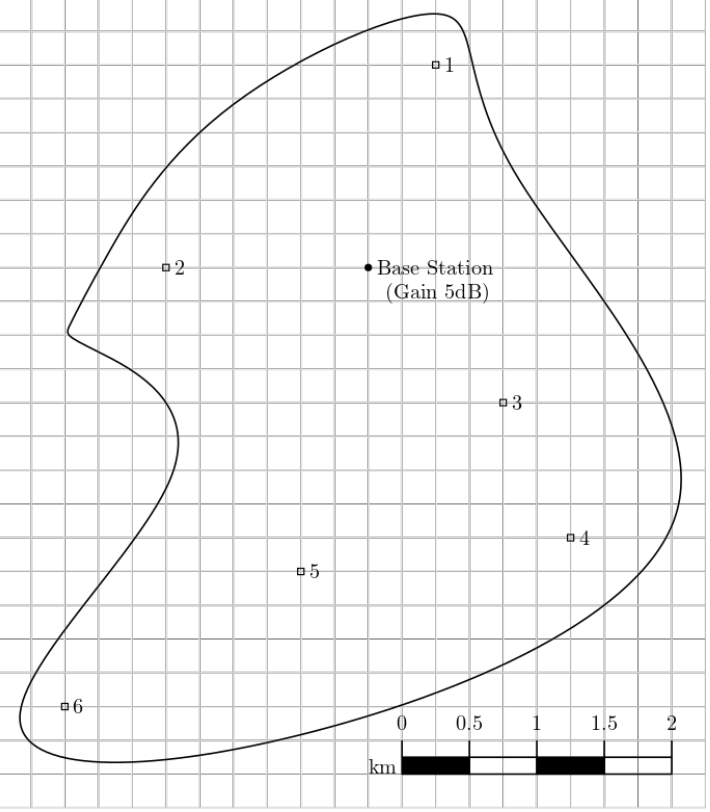
Figure 3. Scale map of island for computation of Free Space Path Loss